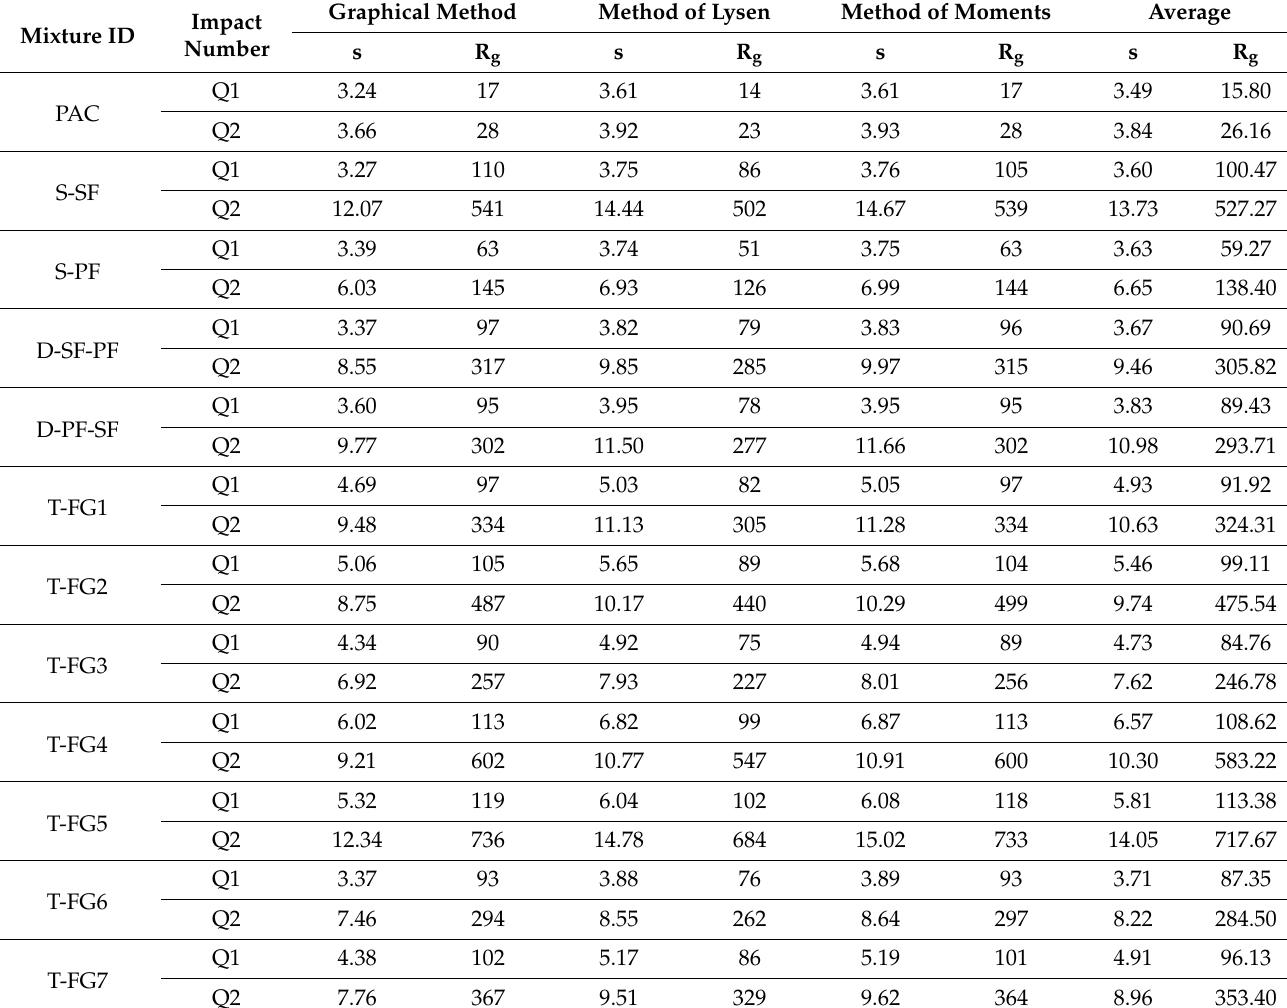
Table 4. Weibull parameters obtained using three